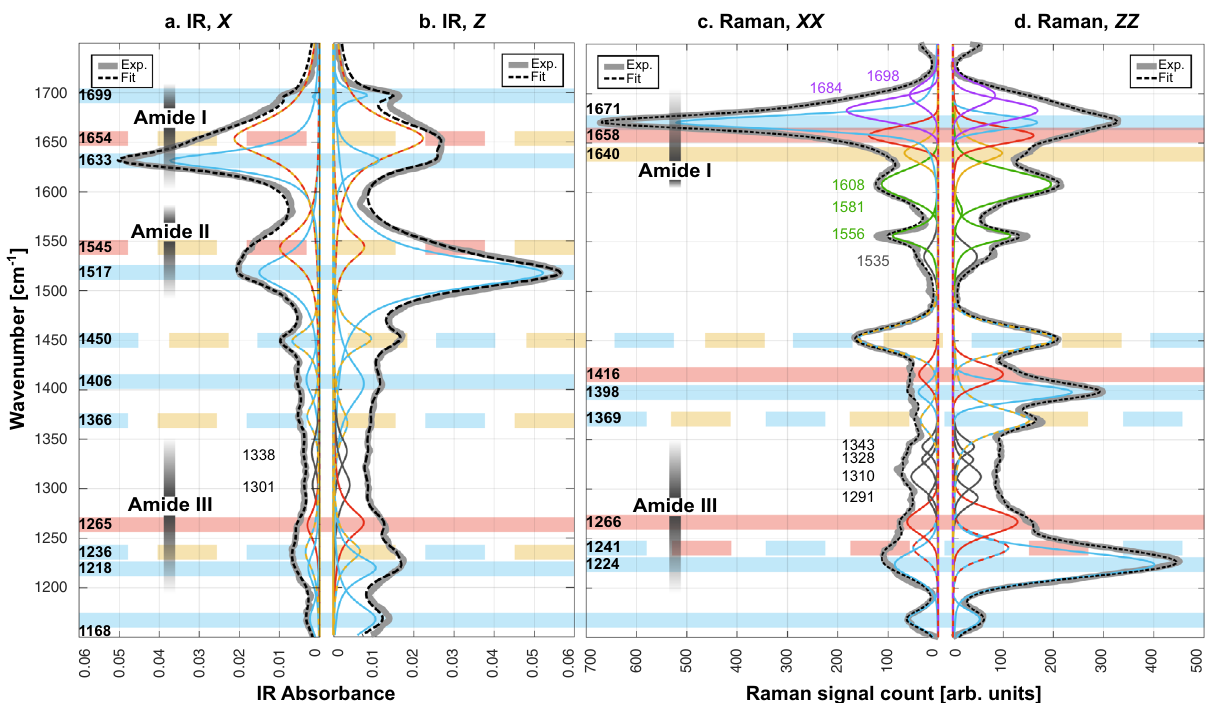
Fig. 2 Polarized vibrational spectra. p-FTIR ( a , b ) and p-Raman ( c , d ) spectra measured experimentally (Exp.) of single Loxosceles spider silk ribbons (thick gray lines) with polarizations in X and Z directions, in the plane of the ribbon. Dashed, black line: multi-peak fi t; all constituting sub-peaks shown in colors. Blue, purple, red, and yellow peaks are assigned to β -sheet, β -turn, helical, and random coil peaks, repsectively. Green peaks represent amino acid residues with aromatic side-chain groups. Gray peaks are unassigned. The colored horizontal bars represent known peaks from the literature, with colors matching the secondary structure